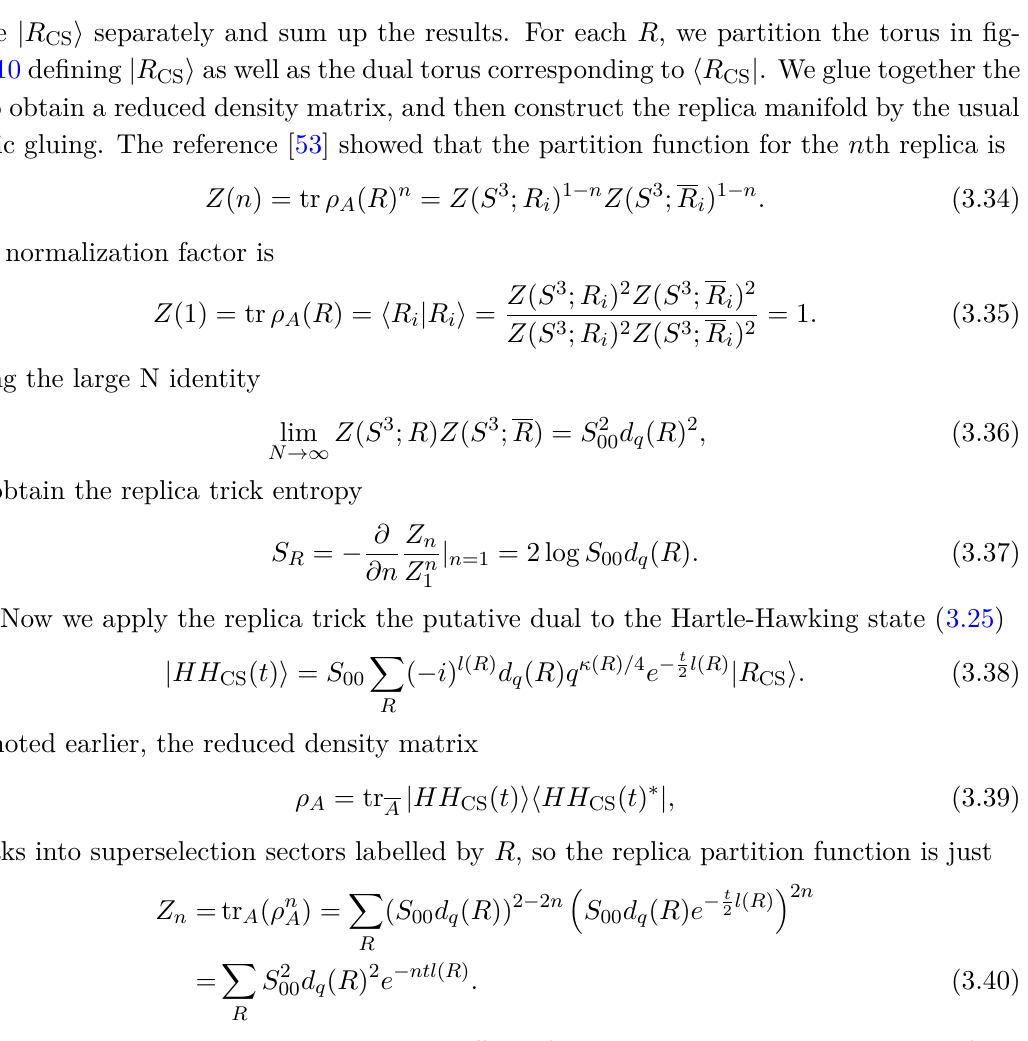
Figure 10 . Separated solid torus with a Wilson loop operator